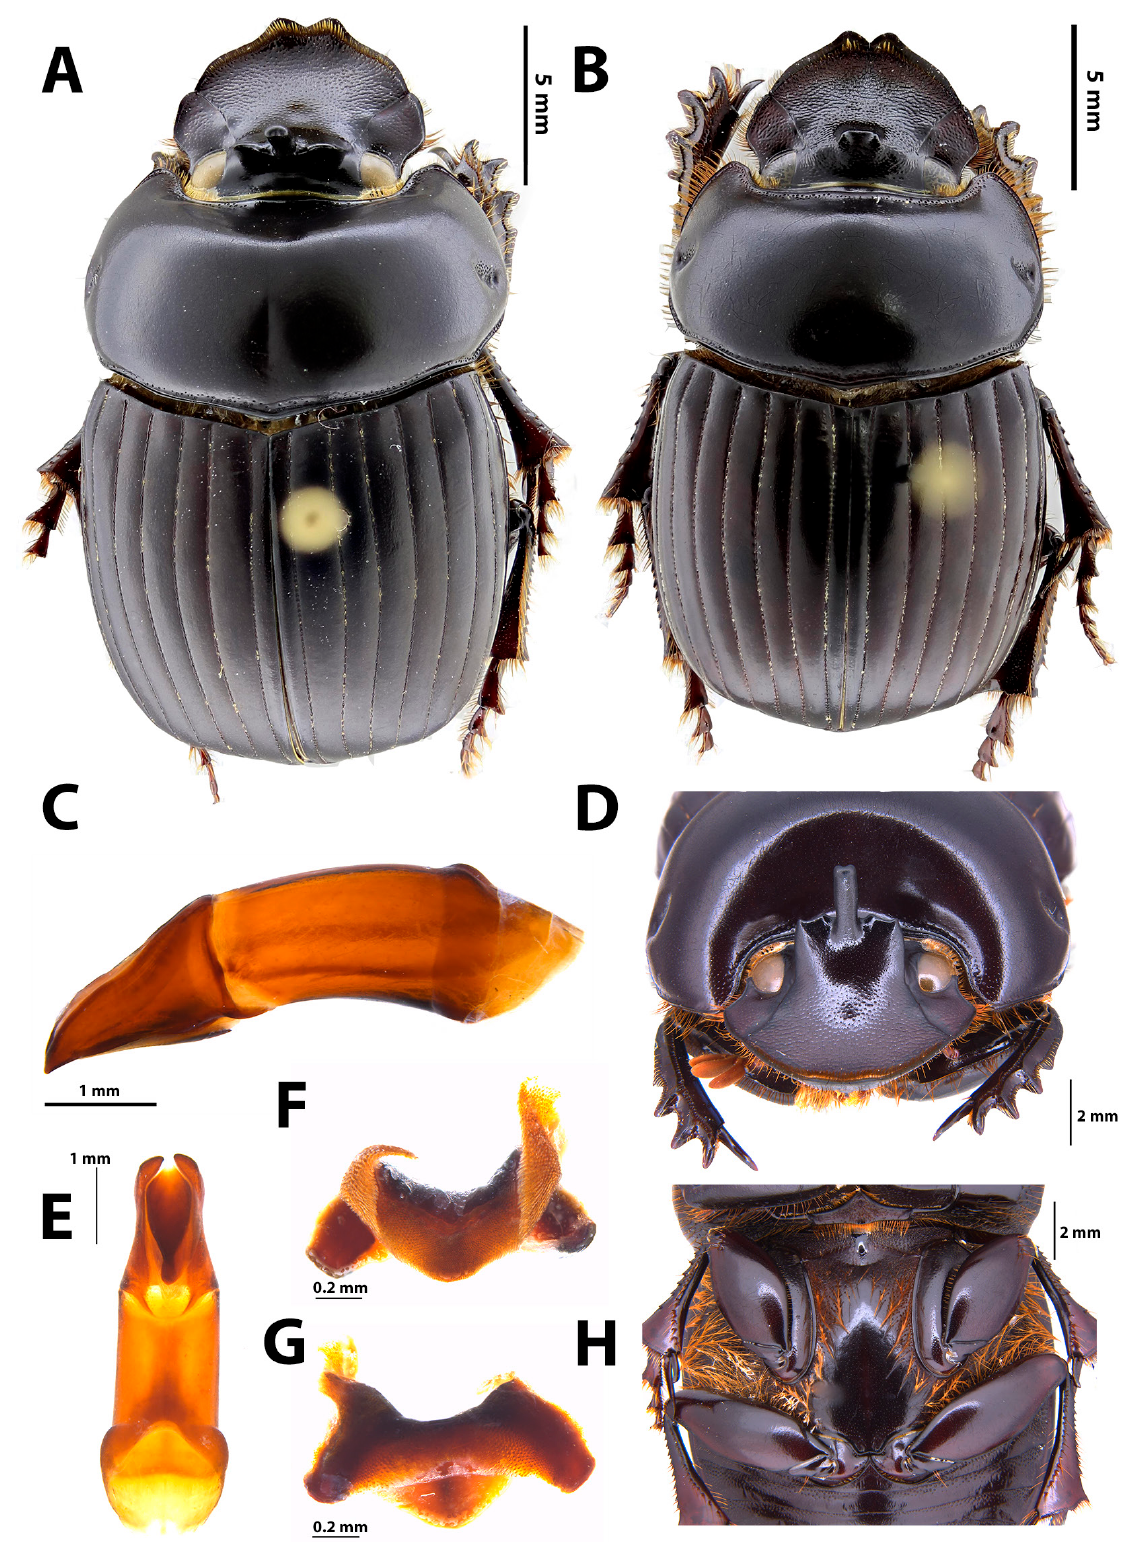
Fig. 7. Dichotomius deyrollei (Harold, 1869). A–B . Dorsal habitus. A . ♂. B . ♀. C . Lateral view of the aedeagus. D . Anterior view of the head cephalic carina. E . Ventral view of the aedeagus. F–G . Lamella copulatrix. H . Metasternum dense